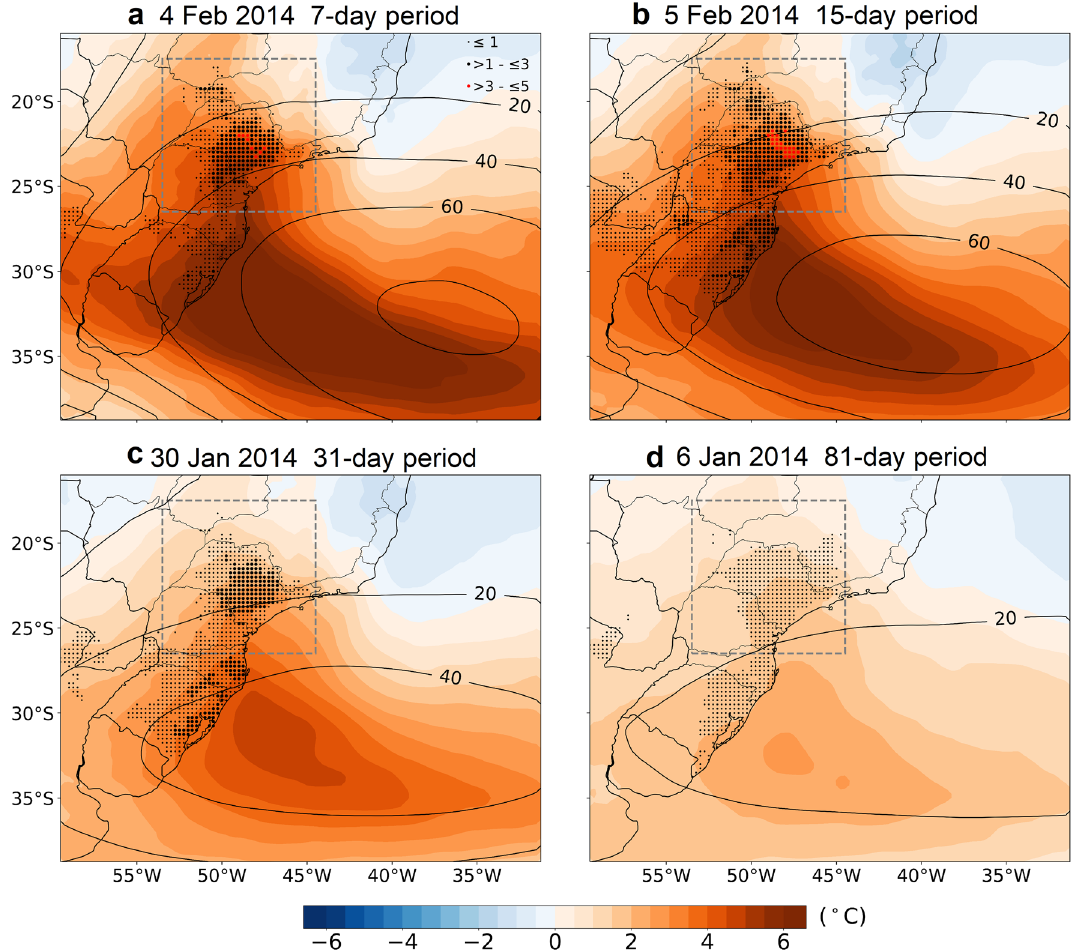
Figure 2. Characterization of the synoptic conditions for the 2013/2014 summer during the days having a maximum area covered by record-breaking temperatures at different temporal scales. Shading shows the spatial distribution of the 850-hPa temperature (°C) anomalies and contours the spatial distribution of the 500-hpa geopotential height (gpm) anomalies (relative to the 1981–2010 period) for 7-day ( a ), 15-day ( b ), 31-day ( c ) and 81-day average periods ( d ) centered on the day indicate at the top of each panel. The dots highlight the grid- points with record-breaking land surface temperature anomalies during the respective average periods. The size and the color are proportional to the exceedance over the previous